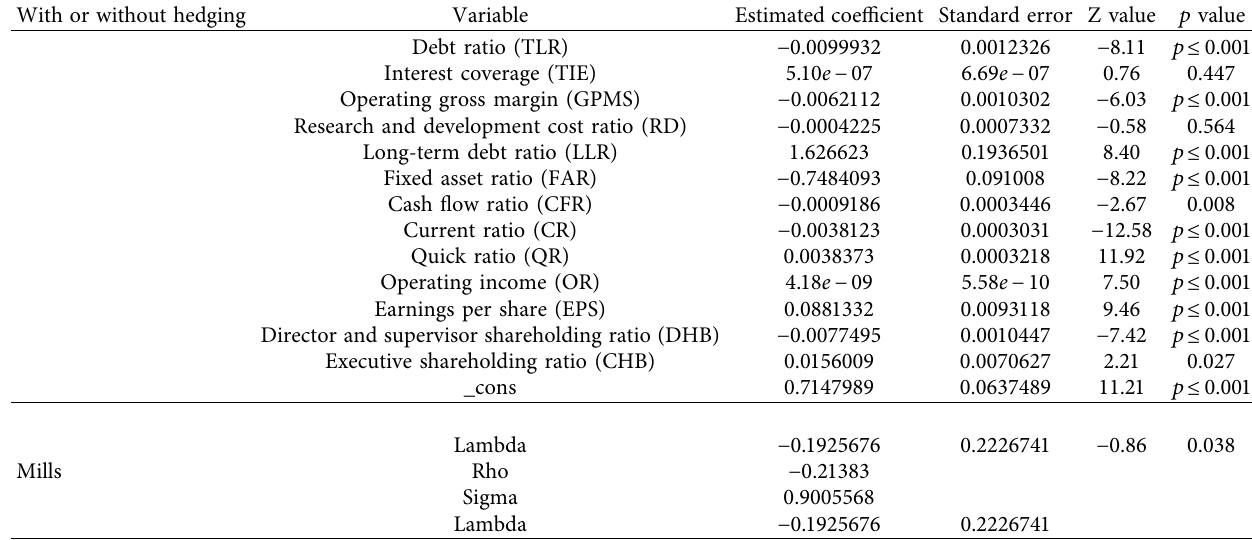
Table 9: Logistic model estimation